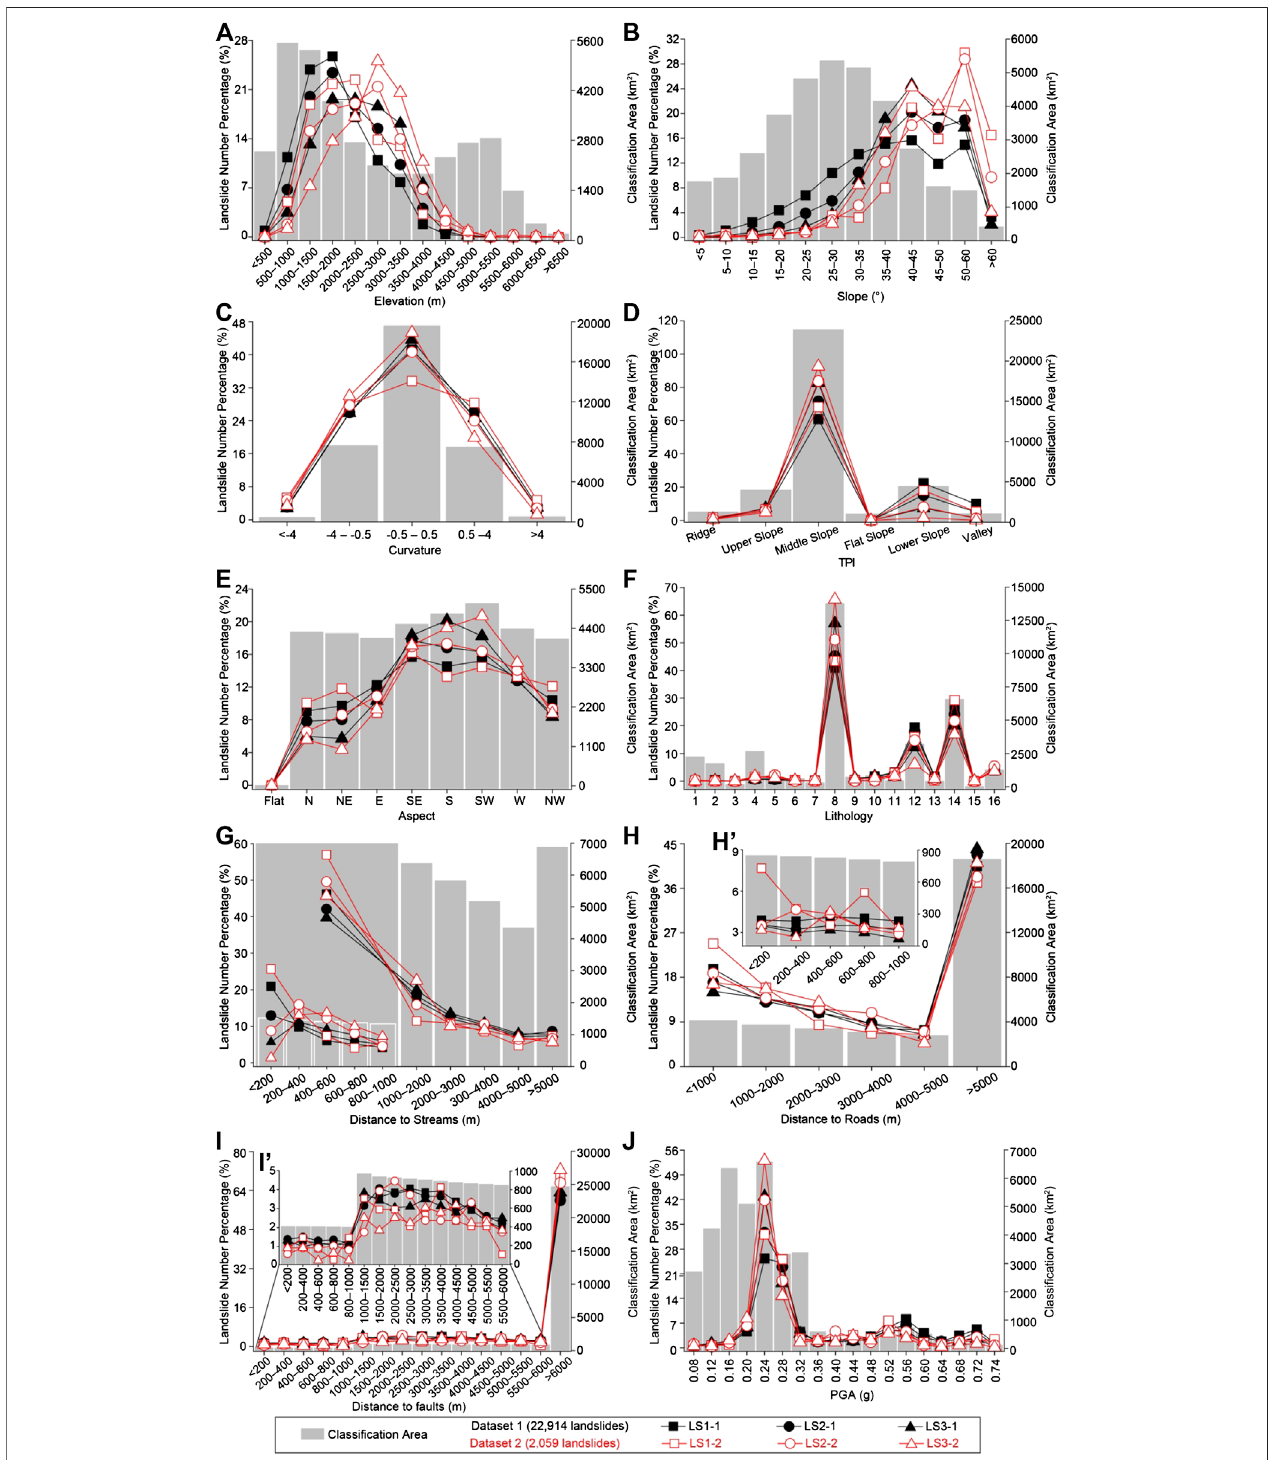
FIGURE7| Analysesofthethreegeomorphometrictypesoflandslidesvs.controlfactors: (A) elevation; (B) slope; (C) curvature; (D) slopeposition/TPI; (E) aspect; (F) lithology; (G) distance from streams; (H) distance from roads and (H ’ ) shows the landslide distribution within 1 km from the roads; (I) distance from faults and (I ’ ) showstheenlargestatisticalplotofthedistance fromfaults;and (J) PGA. Figure5 showsthedistributionofbedrockandprovidesdescriptions. LS1-1(L/W ≤ 2),LS2-1 (2 < L/W ≤ 4), and LS3-1 (L/W > 4) are geometry-based types of landslides for Dataset 1 which includes 22,914 landslides; LS1-2 (L/W ≤ 2), LS2-2 (2 < L/W ≤ 4), and LS3-2 (L/W > 4) are for Dataset 2 which includes 2,059 landslides.